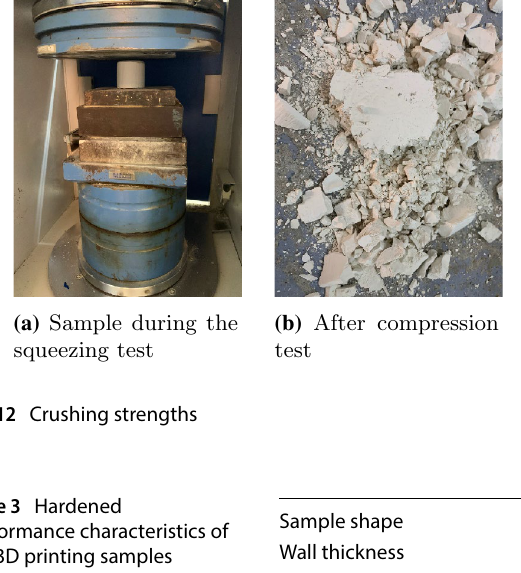
Table 3 Hardened performance characteristics of the 3D printing samples